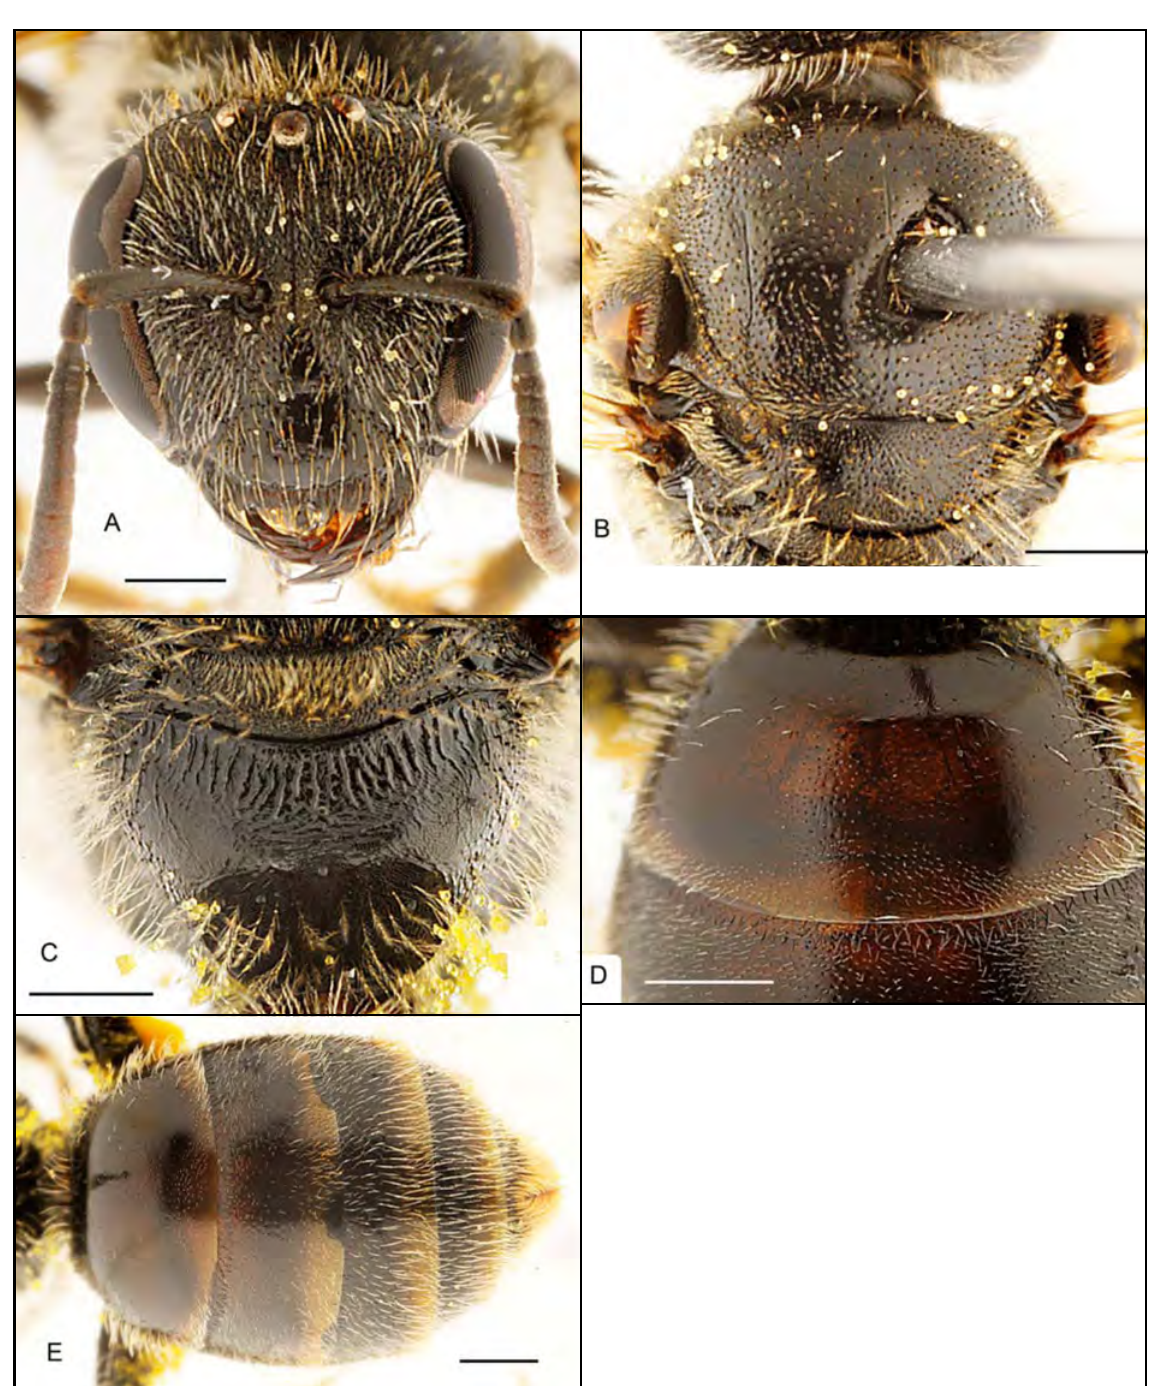
Fig. 7. Lasioglossum ( Capalictus ) tigrinum sp. nov., ♀. A . Head. B . Mesoscutum and scutellum. C . Pro- podeum and metanotum. D . First tergum. E . Metasoma. Scale line = 0,5